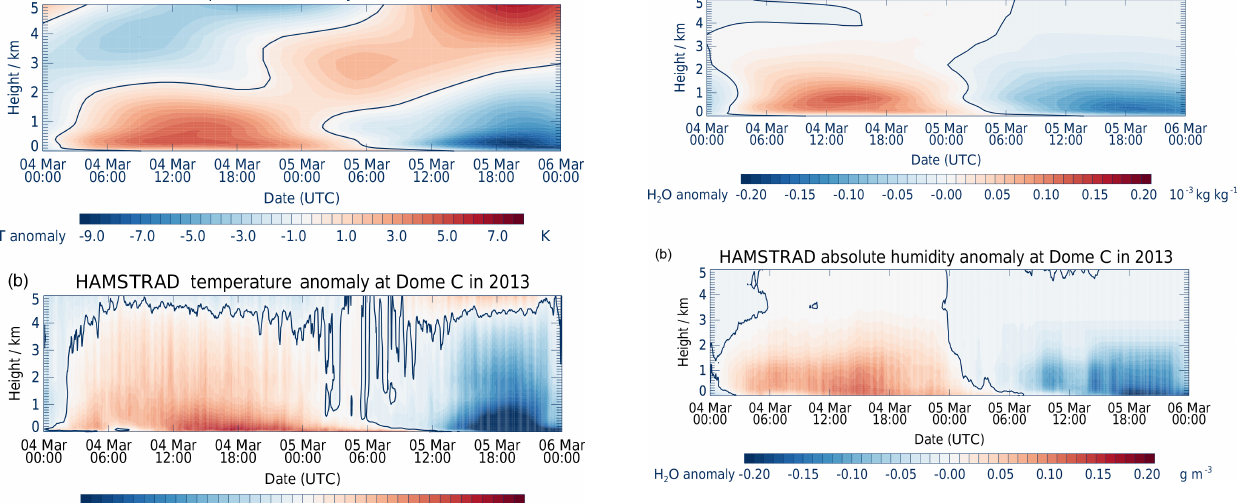
Figure 12. Absolute humidity anomaly from 4 to 5 March 2013 above the Dome C station as calculated by the ARPEGE model (a) and as measured by the HAMSTRAD radiometer (b) .